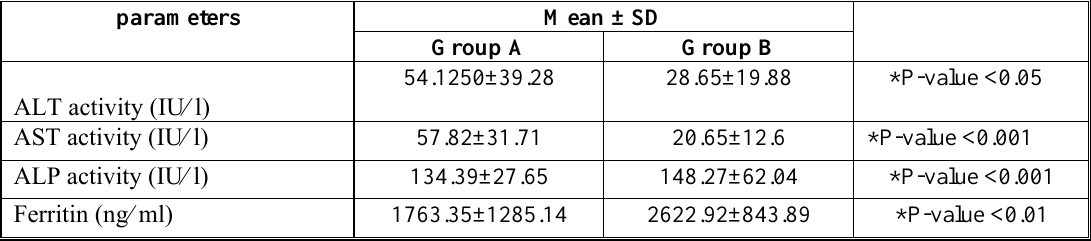
Table7.Differences in Serum ALT, AST, ALP and Ferritin between Group A and